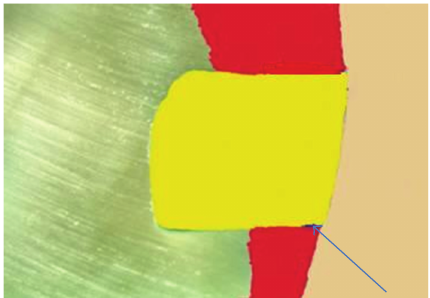
Figure 1: A sample photomicrograph of a tooth specimen showing color coding of tooth structure, filling material, and area of linear dye penetration (arrow).